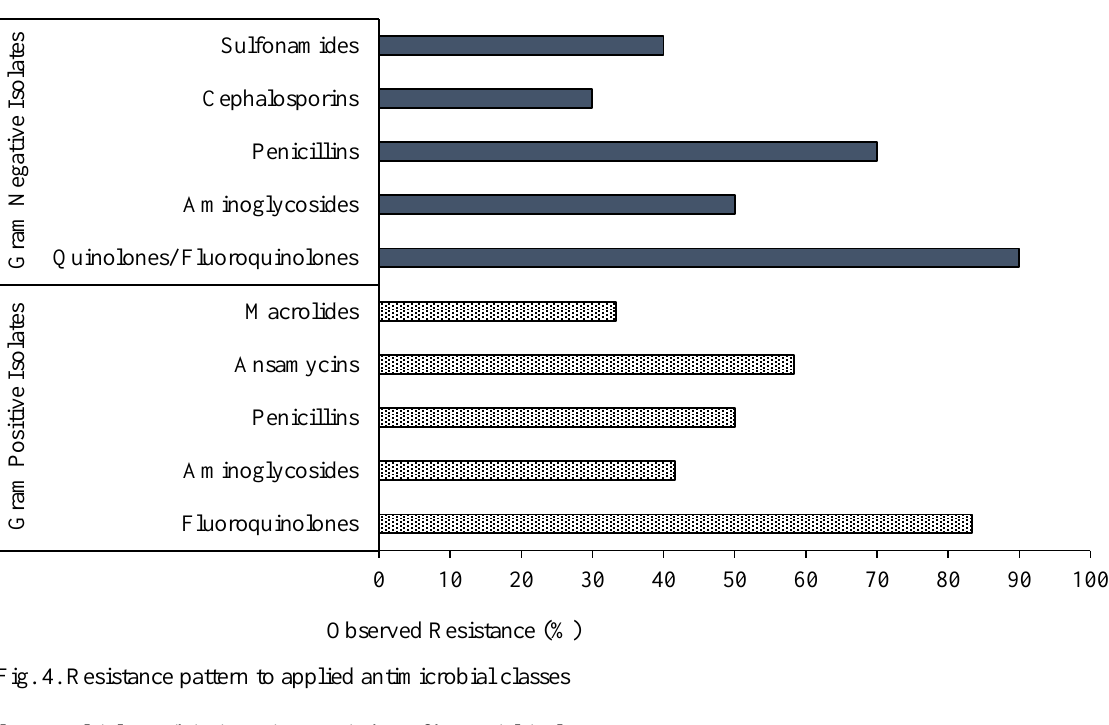
Fig. 3. Observed resistance in gram-negative bacterial isolates (AU: augmentin-amoxicillin/clavulanic acid, 10 μg; OFX: ofloxacin, 20 μg; CPX: ciprofloxacin, 10 μg; PEF: pefloxacin, 10 μg; GN: gentamicin, 10 μg; S: streptomycin, 30 μg; CEP: cephalexin, 10 μg; SXT: septrin-sulfamethoxazole/trimethoprim, 30 μg; PN: ampicillin, 30 μg; NA: nalidixic acid, 30 μg)